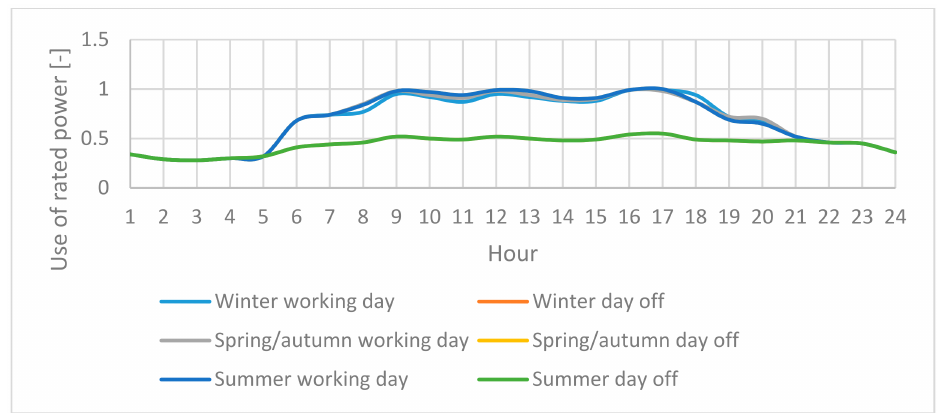
Figure 6. Representative profiles for industrial